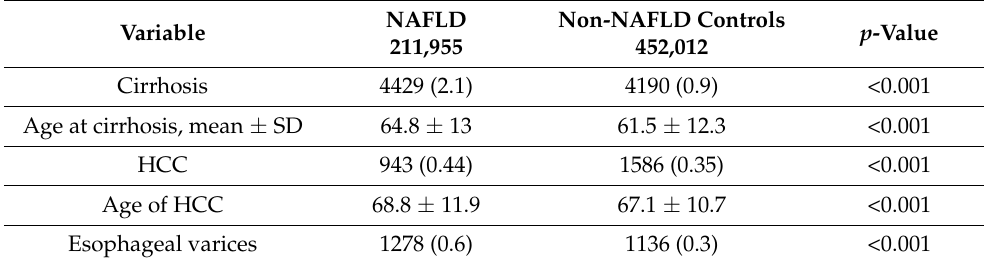
Table 3. Complications and mortality among NAFLD and non-NAFLD